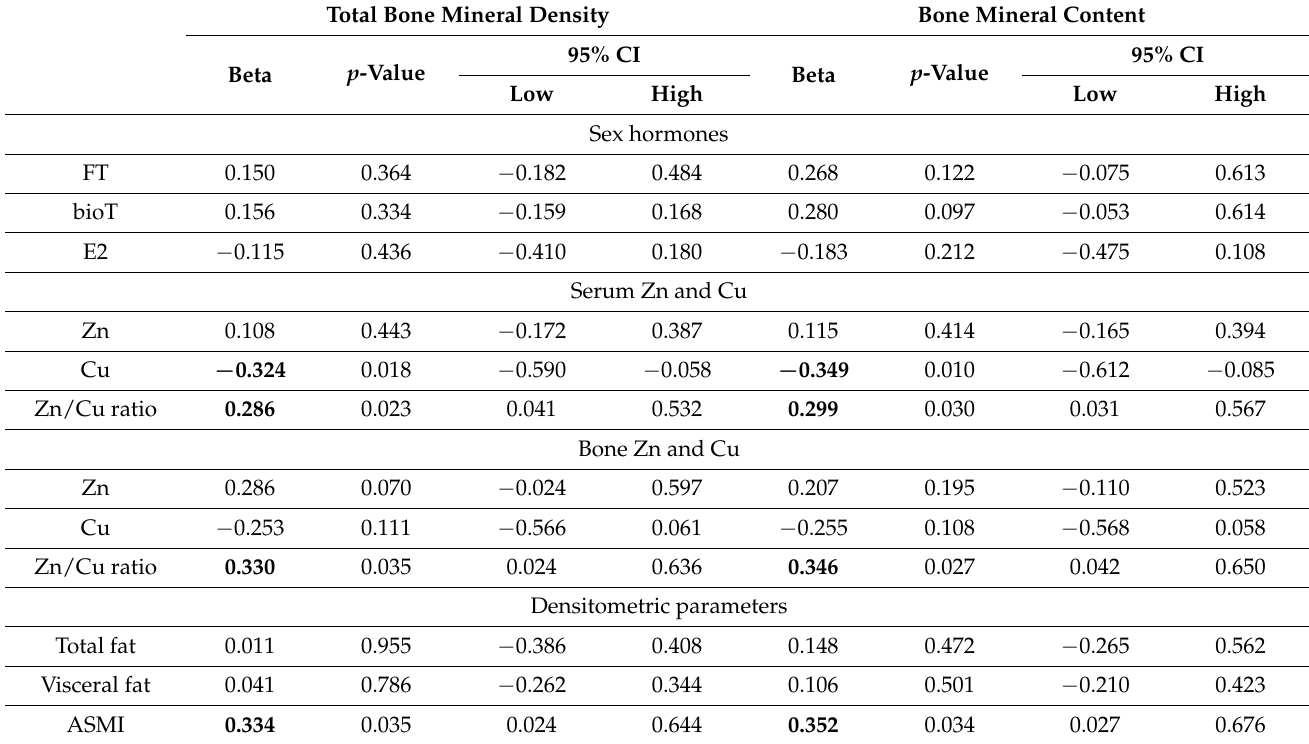
Table 5. Regression analysis adjusted for age and BMI. CI, confidence interval.